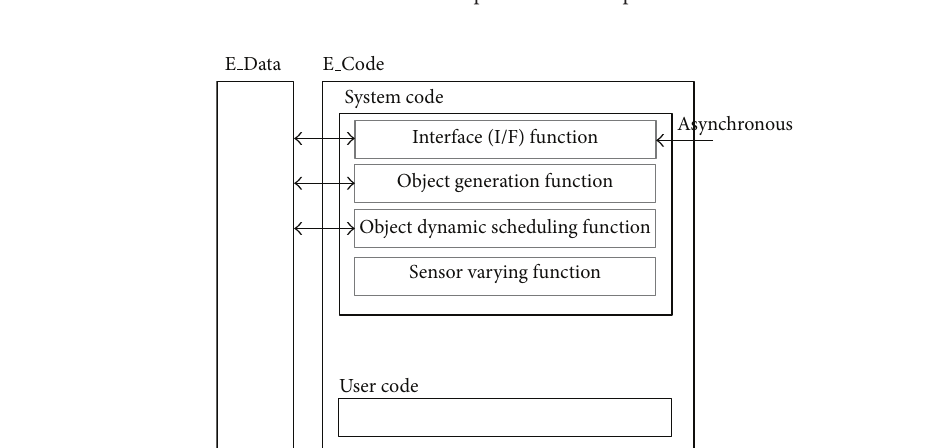
Figure 5: Sensor representation script format.